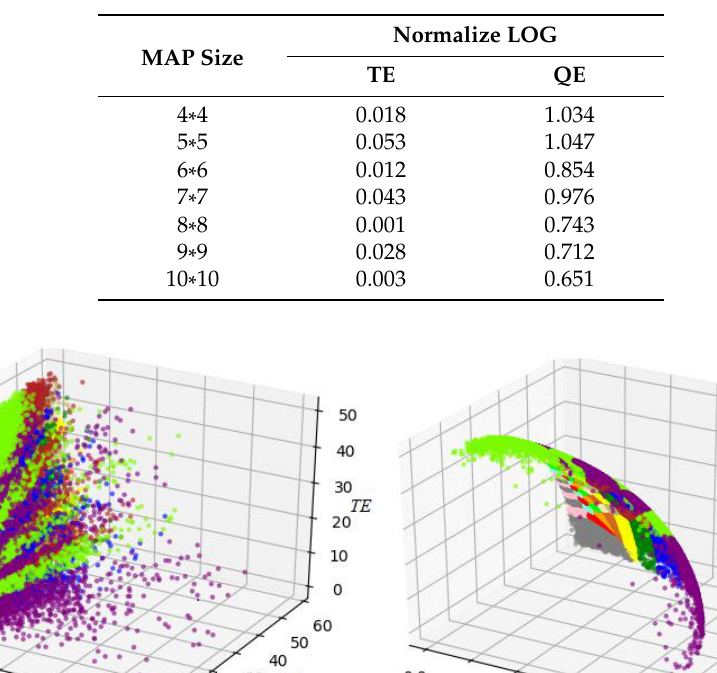
Table 5. Quality measures (topographic error and quantization error) of di ff erent map sizes.